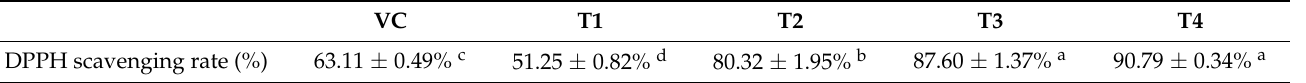
Table 2. DPPH scavenging activity of VC and extracts (n =